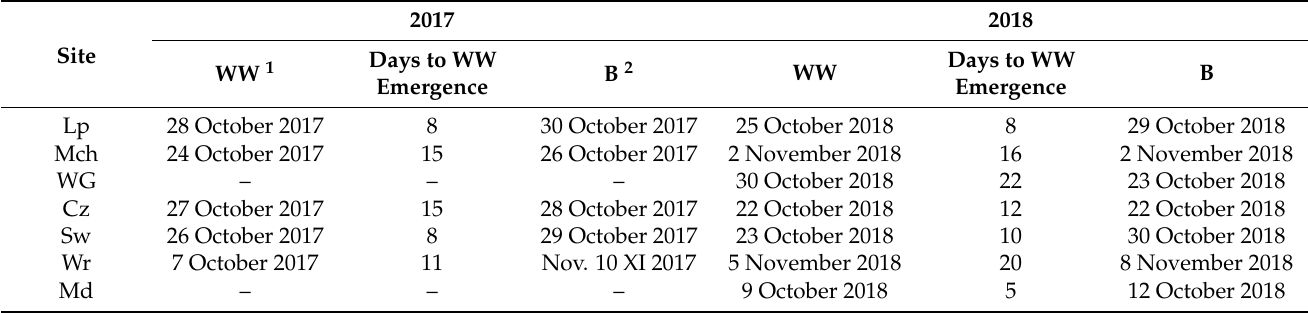
Table 5. Dates of winter wheat and bentgrass emergence, and the number of days from wheat sowing until